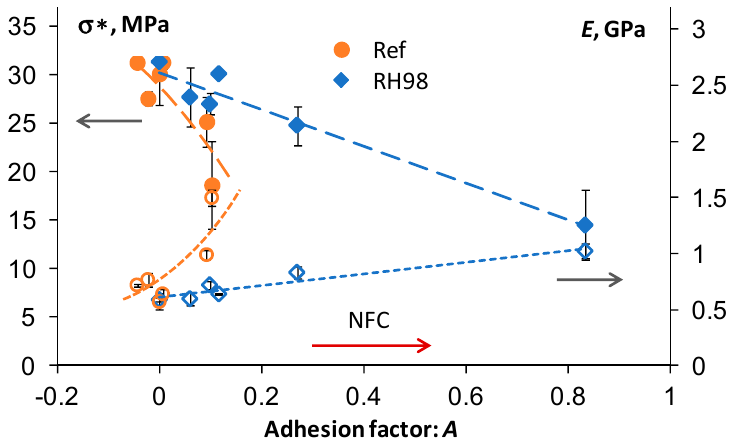
Figure 12. Strength (filled symbols) and elastic modulus (open symbols) as functions of the adhesion factor A for reference and RH98 PBS/NFC samples. Lines are approximations.